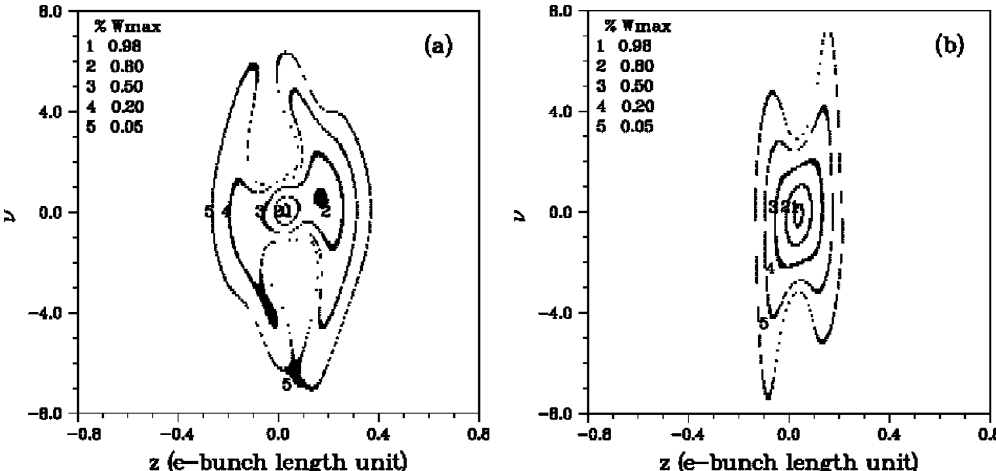
FIG. 10. Fifth harmonic: (a) at the knee, W max ¼ 1 : 34 (cid:2) 10 (cid:1) 5 ; (b) at the first peak, W max ¼ 6 : 39 (cid:2) 10 (cid:1) 2 ; same parameters as in Fig. 6.